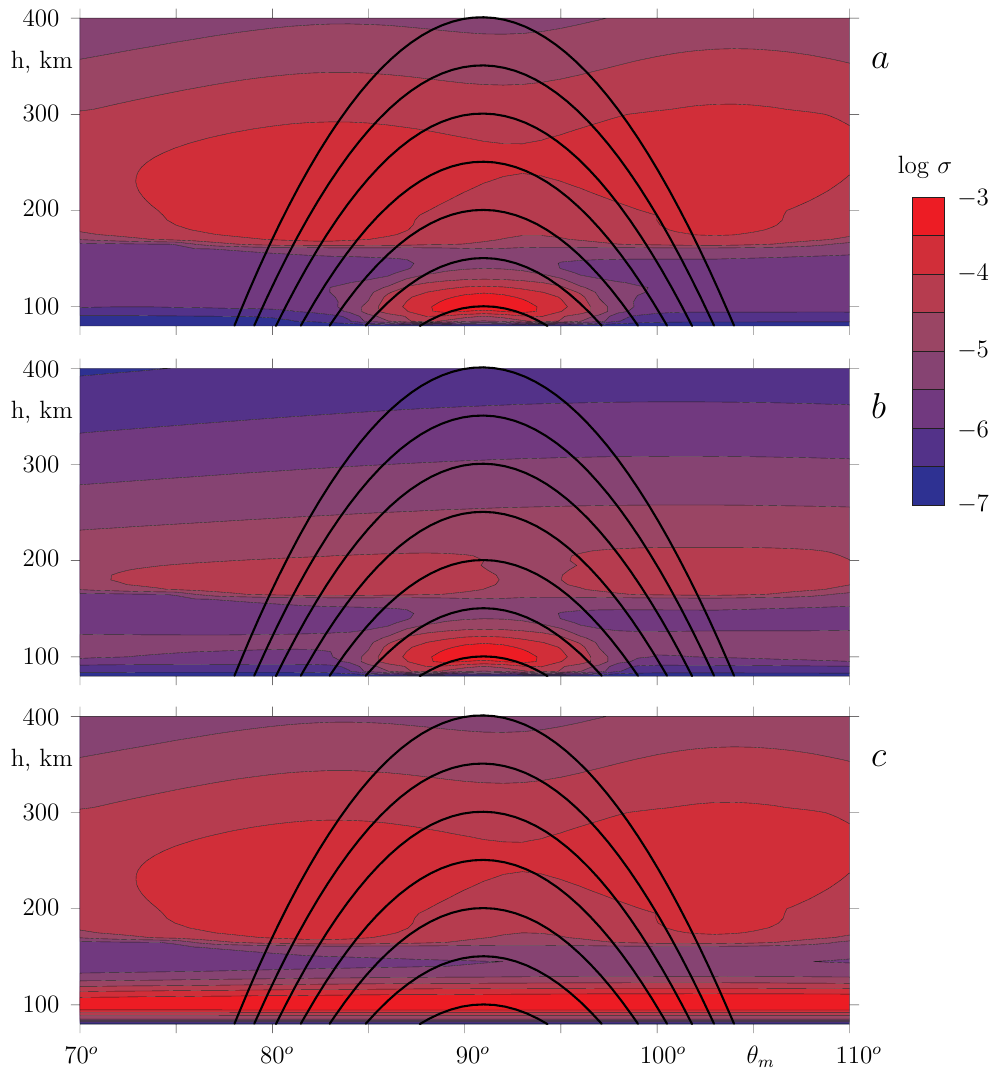
Fig. 8. Conductivity distributions at the surface that consists of the magnetic field lines which cross the geomagnetic equator above the point ϕ m = 0. There is midnight in this point. A few magnetic field lines of this sort are plotted. Panel (a) is for log 10 (σ d ) for a short-term process, panel (b) is for log 10 (σ d ) for a long-term process, panel (c) is for log 10 (σ C ) for a short-term process, where conductivities in S/m units are used. The abscissa is the geomagnetic colatitude θ m and the ordinate h is the height. The color scale is common for all panels. The values at √ the neighbor plotted contours differ 10 ’ 3 . 2